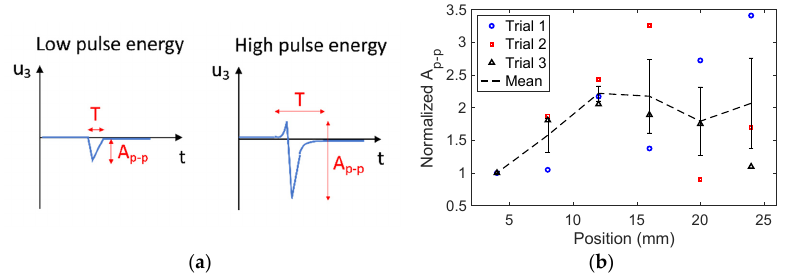
Figure 7. ( a ) Schematic representatives of V-shaped waveforms in Figure 6 for low pulse energy and high pulse energy, ( b ) Normalized peak-to-peak amplitude evolution with propagation distance for Ti-6Al-4V AM, with mean and standard deviation.